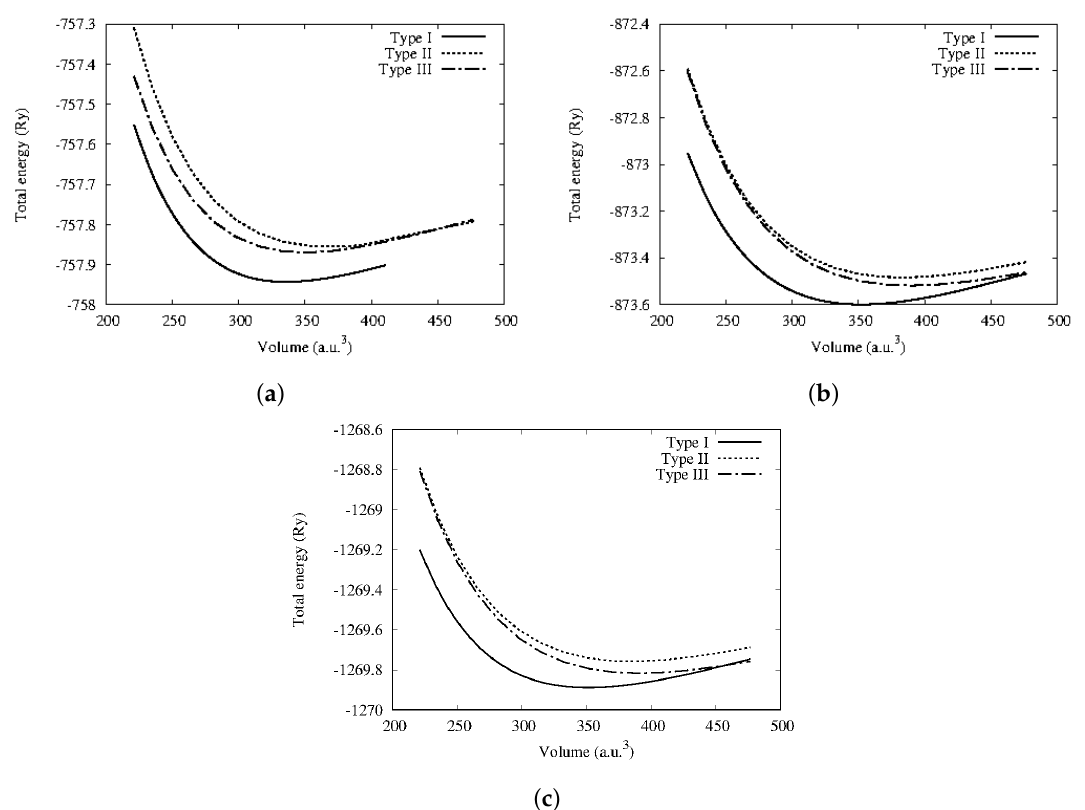
Figure 2. Calculated total energy as a function of volume in ferromagnetic state for the three possible structural phases ( a ) CoCrSb, ( b ) CoMoSb, and ( c ) CoWSb,